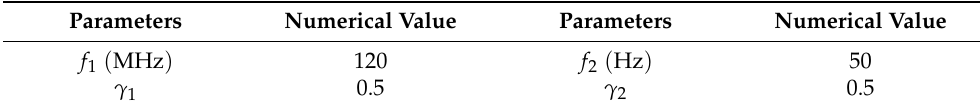
Table 6. Jamming simulation parameters.